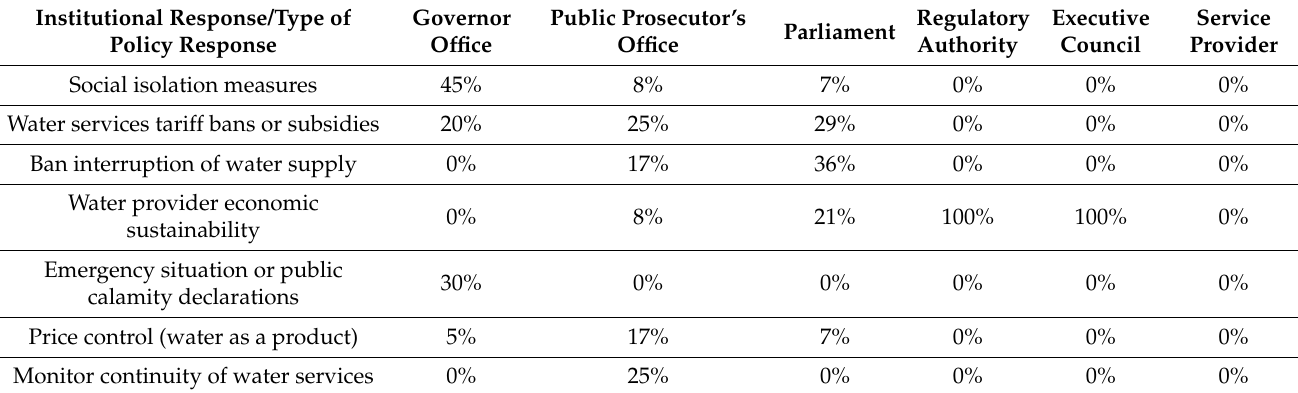
Table 5. Percentage of institutional response per type of policy responses.